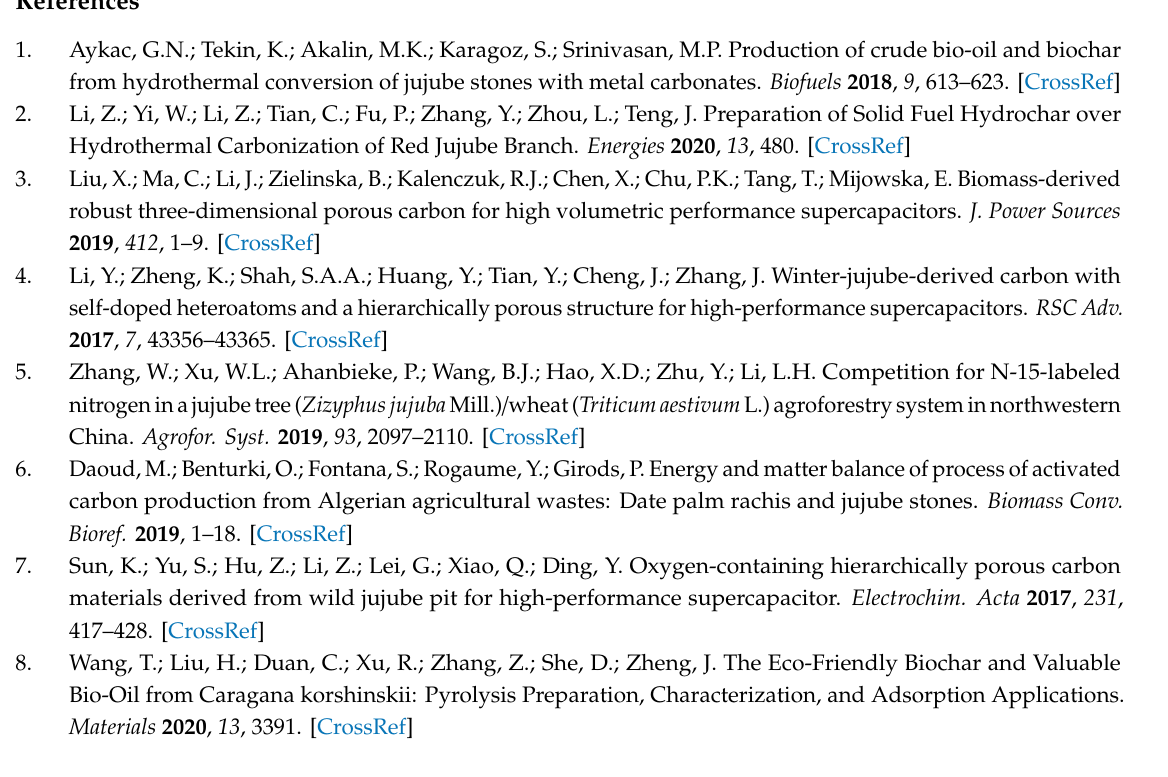
Table S1. Supplementary elemental analysis of JB using the dry base; Figure S1. BJH-adsorption-pore size distribution of JB at 600 ◦ C / 2 h. Figure S2. X-ray photoelectron spectra of JB at 600 ◦ C / 2 h. (a) for C 1 s; (b) for N